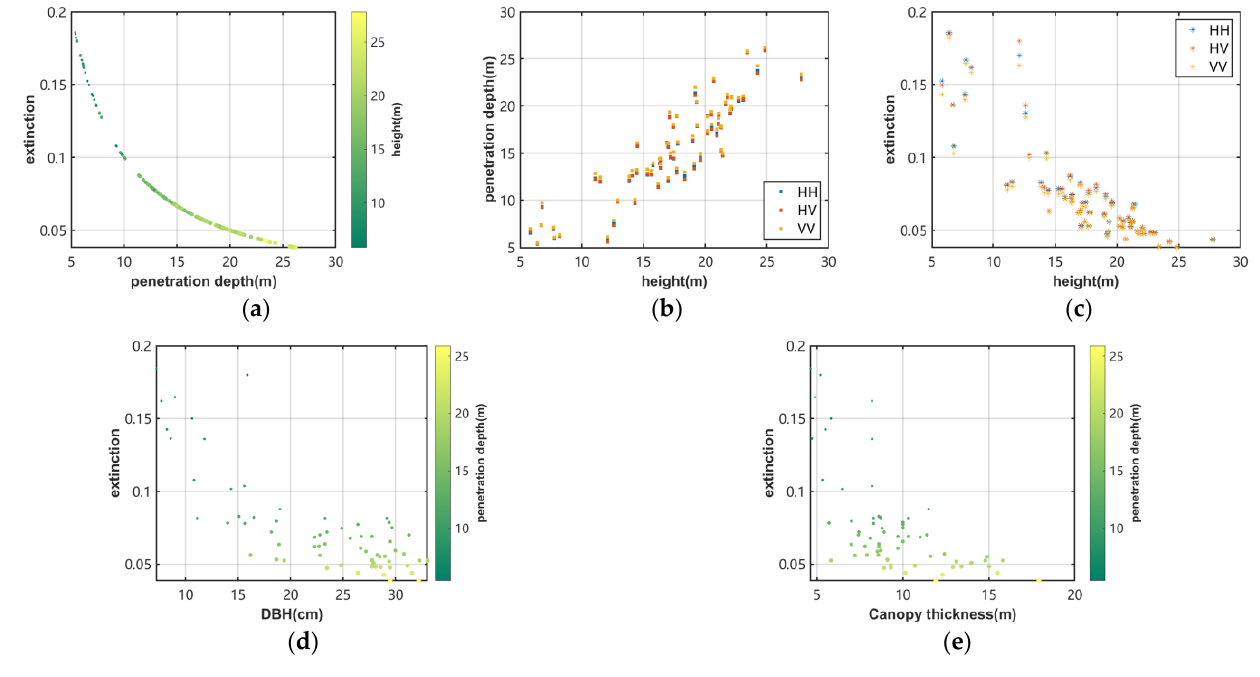
Figure 11. Diagram of the relationship between the extinction coefficient and the penetration depth, where the extinction coefficient is considered to be the attenuation coefficient and reciprocal of the penetration depth. ( a ) Penetration depth vs. extinction coefficient (the shade of the scatter color is the magnitude of the forest height). ( b , c ) are the scatter relationship diagrams of the mean tree height and the penetration depth and the extinction coefficient of HH, HV and VV polarization, respectively. ( d ) Mean canopy thickness vs. extinction coefficient (the shade of the scatter color is the magnitude of penetration depth). ( e ) Mean DBH vs. extinction coefficient (the shade of the scatter color is the magnitude of the penetration depth).